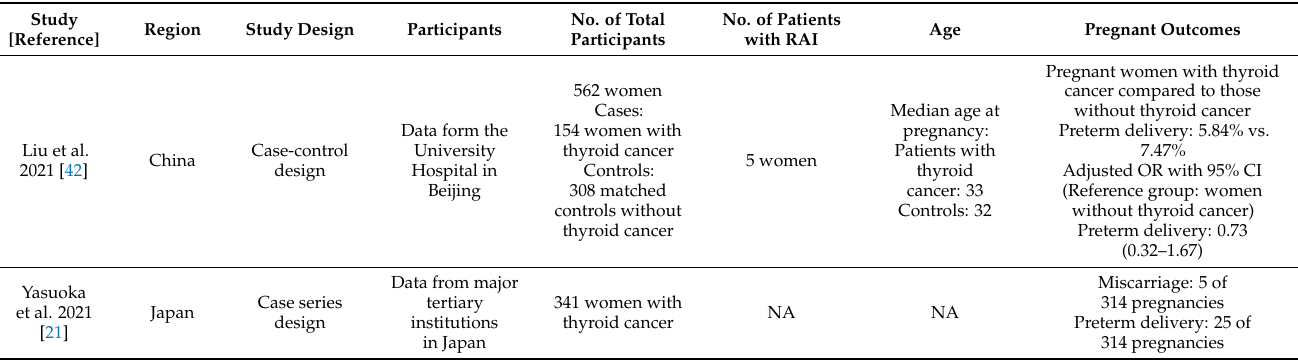
Table 1. Study characteristics of the included